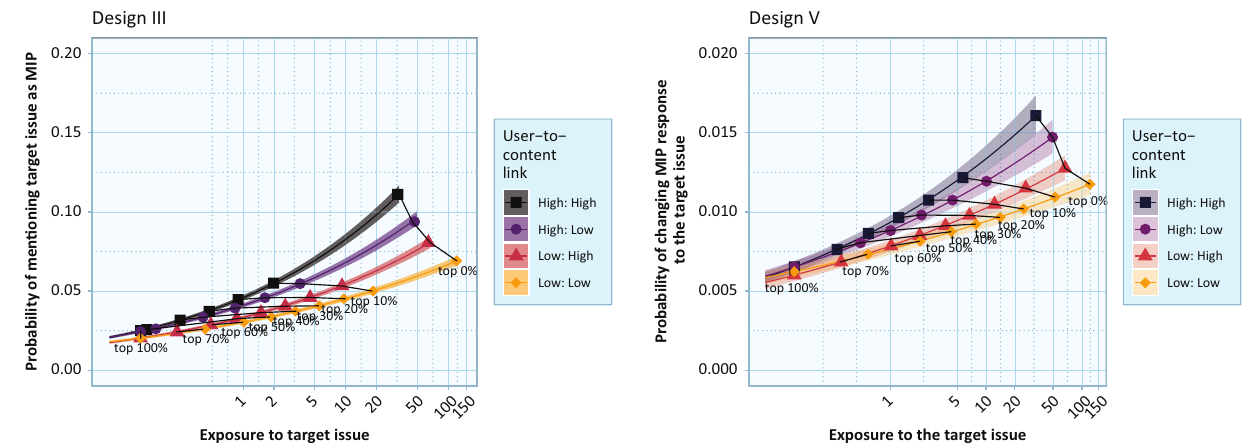
Figure 3. Issue exposure effects on individual probability of mentioning the issue as MIP. aggregate‐level (I, II, and IV) than for individual‐level (III and V) studies and is greater for static/cross‐sectional (I and III) than for their dynamic/longitudinal (II, IV, and V) counterparts (Figure 4, absolute values). While the aggregate/between design explains up to 27.6% of the variation in public salience of issues, the individ‐ ual/within design explains only up to 0.9% of the vari‐